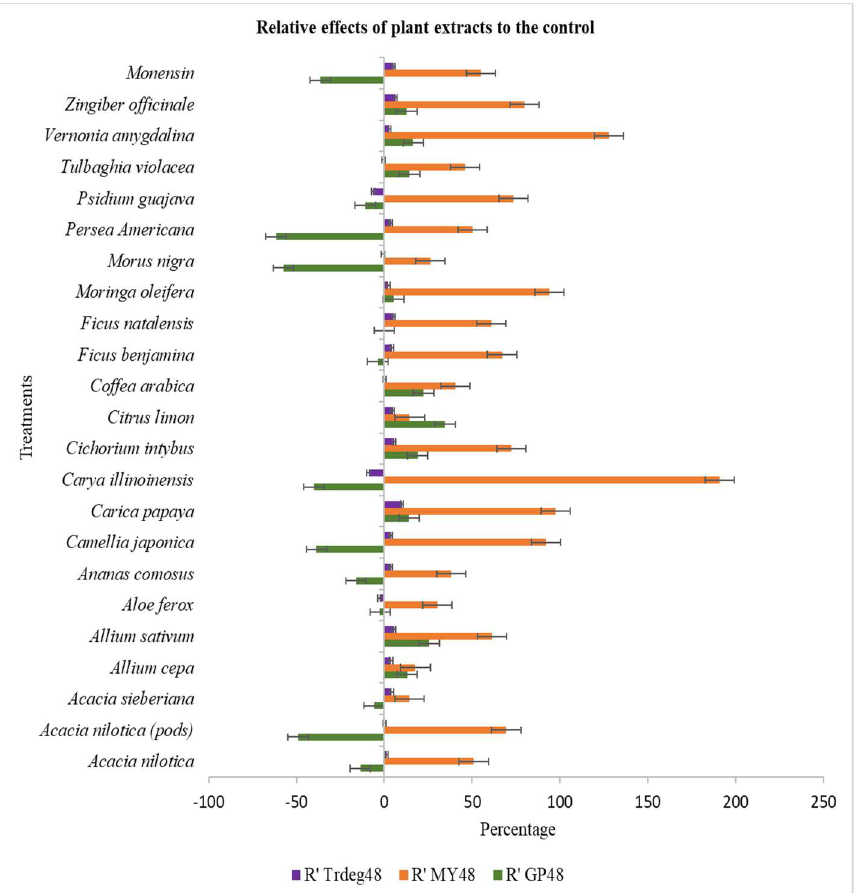
Figure 2. Chart presenting the effects of the treatments (plant extracts and monensin sodium) relative to the control on true degradability, microbial yield, and gas production at 48 h of incubation of Themeda triandra hay. R’ Trdeg—effect on true degradability, R’MY—effect on microbial yield, R’ GP- effect on gas production.